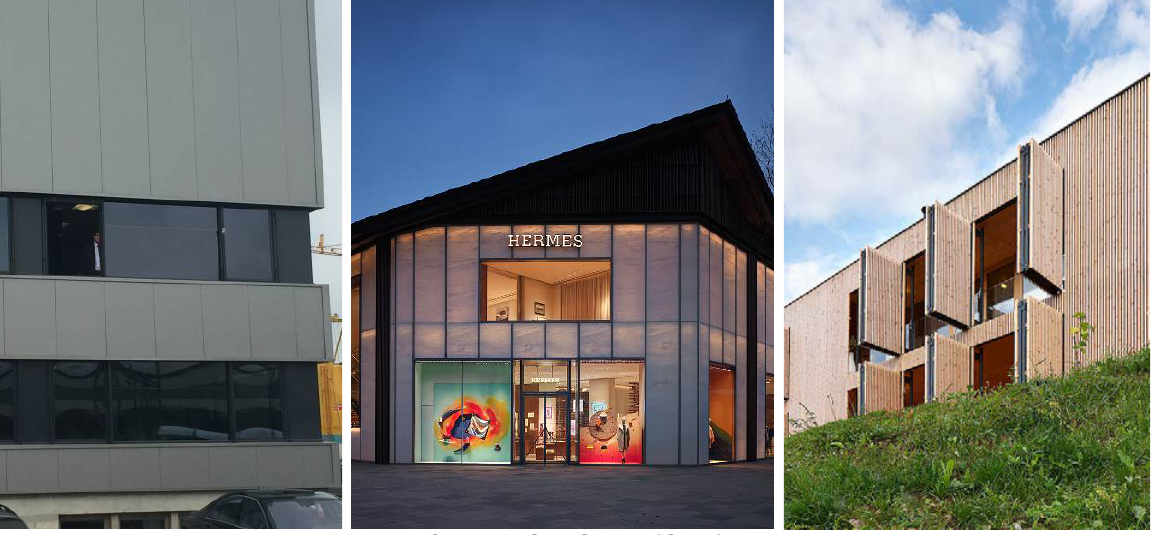
Fig. 2: References in glass, glass&marble, and